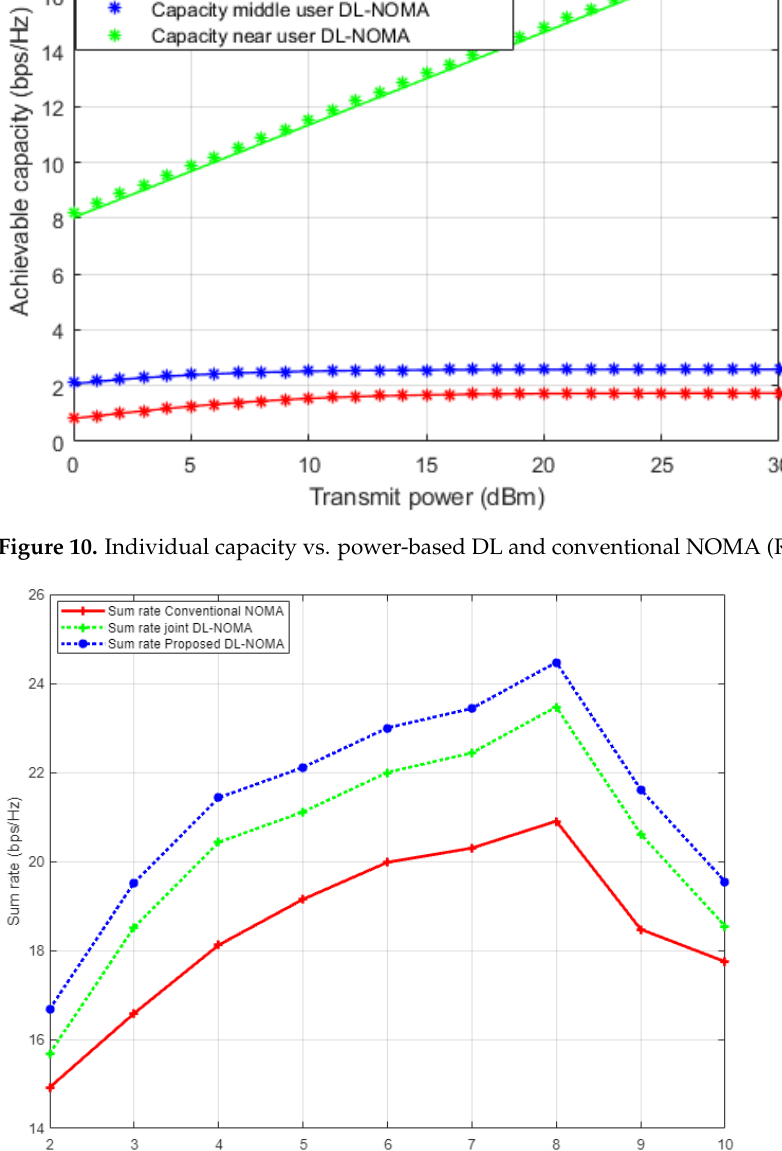
Figure 10. Individual capacity vs. power-based DL and conventional NOMA (Rician Channel).